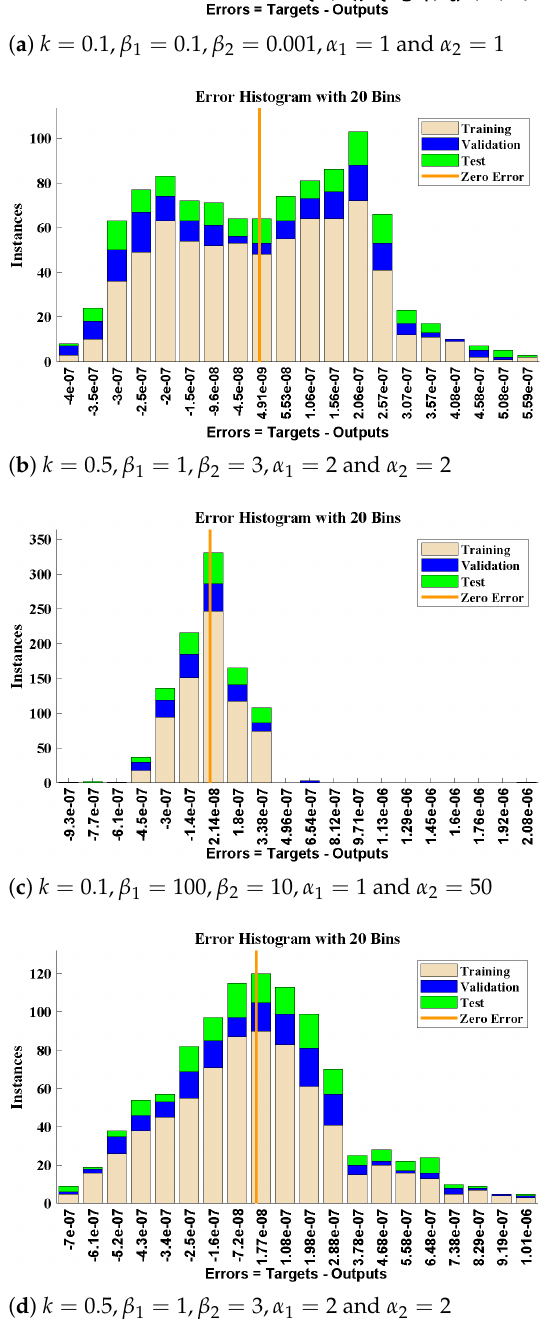
Figure 9. ( a , b ) The error histogram analysis for the concentration of CO 2 and ( c , d ) the errors in solution for the concentration of